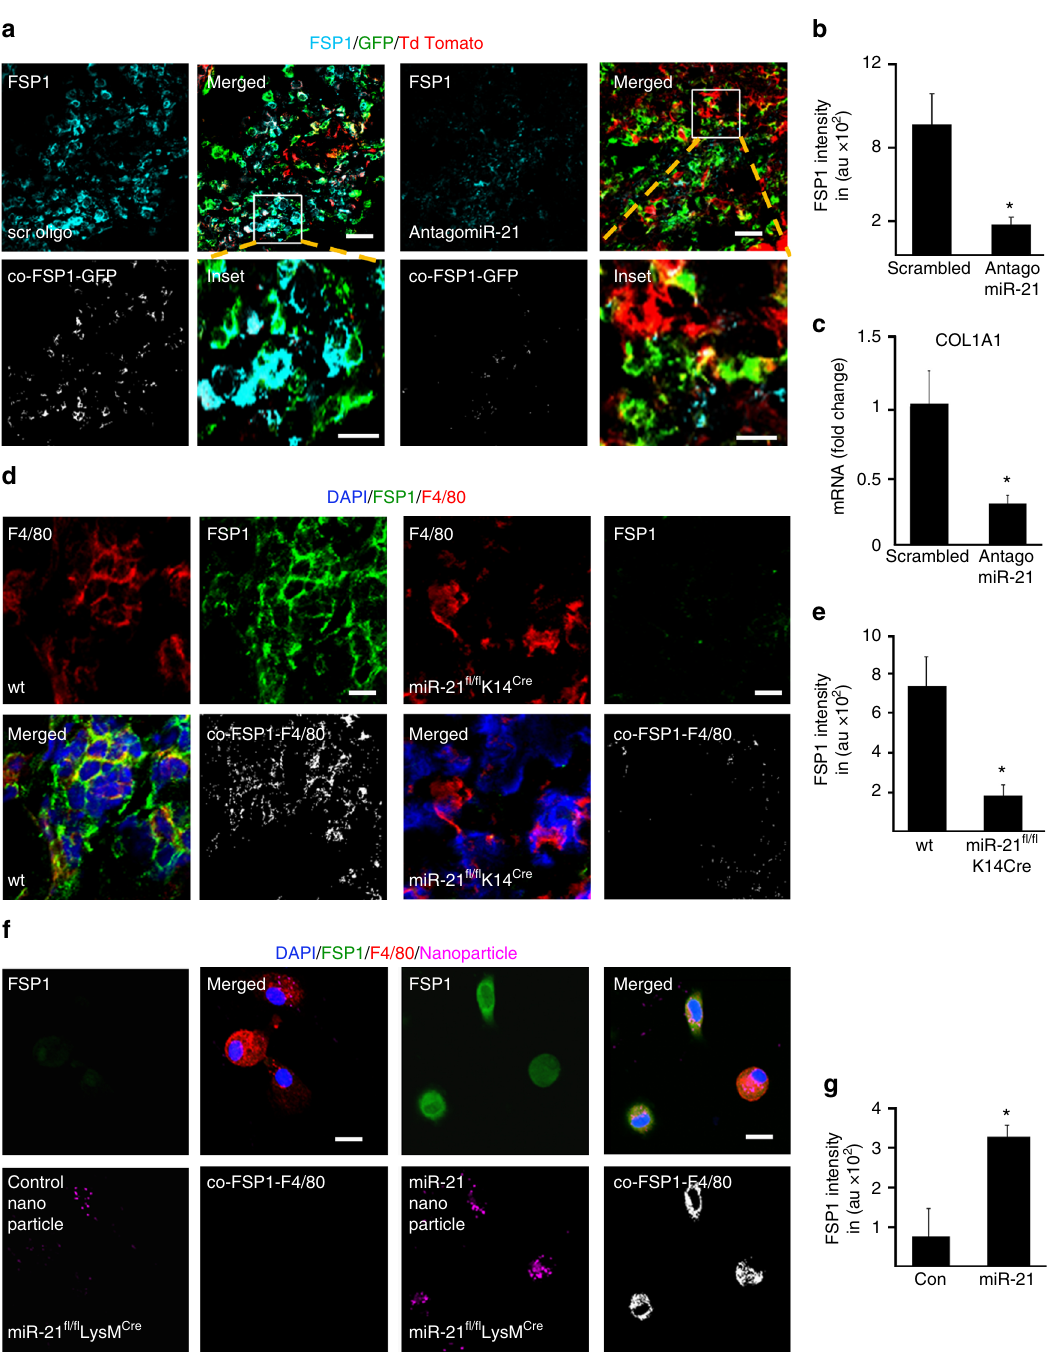
Fig. 8 Keratinocyte-speci fi c depletion of miR-21 impairs macrophage conversion. a FSP1 (cyan) immunostaining and macrophages (GFP + , green) colocalization in d5 wound tissue from LysM Cre Rosa mT/mG mice where antago-miR-21 or scrambled oligo were topically delivered to the wounds, scale bar = 50 µ m, scale bar of inset = 10 µ m. b FSP1 intensity in scrambled and antago-miR-21 delivered mice, n = 5, Student ’ s t test p <0.05. c q-RT-PCR analyisis of COL1A1 expression in LysM Cre Rosa mT/mG mice d5 wound tissues scrambled and antago-miR-21, n = 5, Student ’ s t test p <0.05. d Macrophage (F4/80, red) and fi broblast (FSP1, green) immunostaining of d5 wound tissue from wt and miR-21 fl / fl K14 Cre mice, n = 5, Student ’ s t test p <0.05, scale bar = 10 µ m. e FSP1 intensity analysis in wt (miR-21 fl / fl ) and miR-21 fl / fl K14 Cre mice, n = 5, Student ’ s t test p <0.05. f F4/80 (macrophage, red) and FSP1 ( fi broblast, green) immunostained wound macrophages isolated from miR-21 fl / fl LysM Cre mice. Rescue of FSP1 expression (green) with nanoparticles mediated miR-21 (magenta) delivery, scale bar = 10 µ m. g FSP1 intensity in wound macrophages delivered with miR-21 compared to control mimic, n = 5, Student ’ s t test p with single fl urophores. Gates were set manually. Gating strategy for the fl uor- ophores has been shown in respective fi gures. BD Diva software (BD Biosciences) was used for analysis. Logarithmic scale was used to measure cell fl uorescence. Appropriate IgG control fl uorescence compensation was applied to avoid false positive signals.